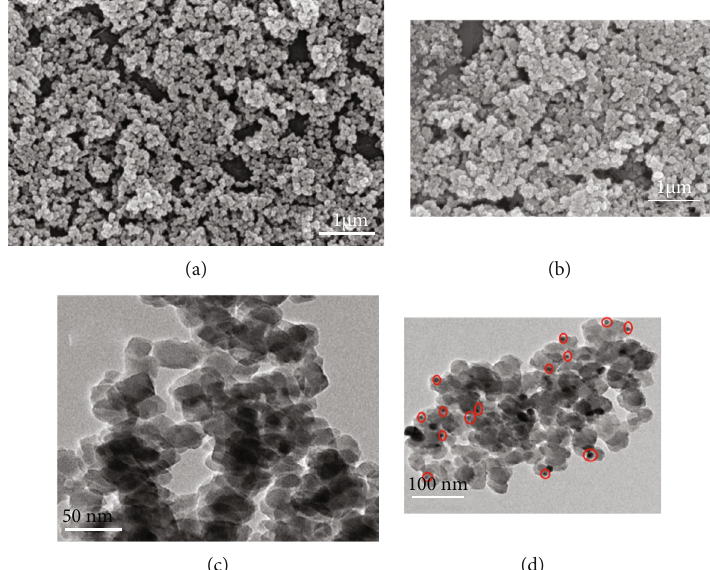
Figure 3: (a) and (c) are SEM and TEM images of UiO-66-NH